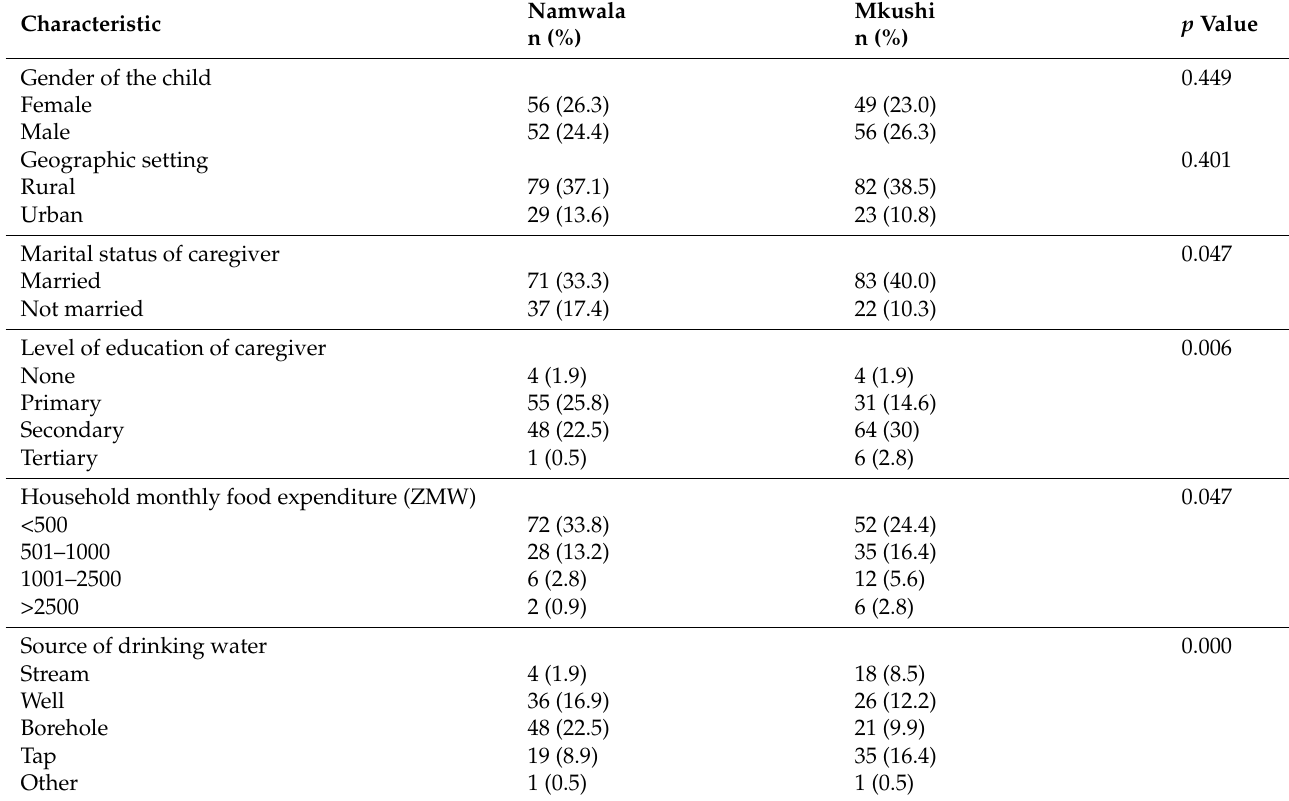
Table 1. Socio-economic and demographic characteristics of the study